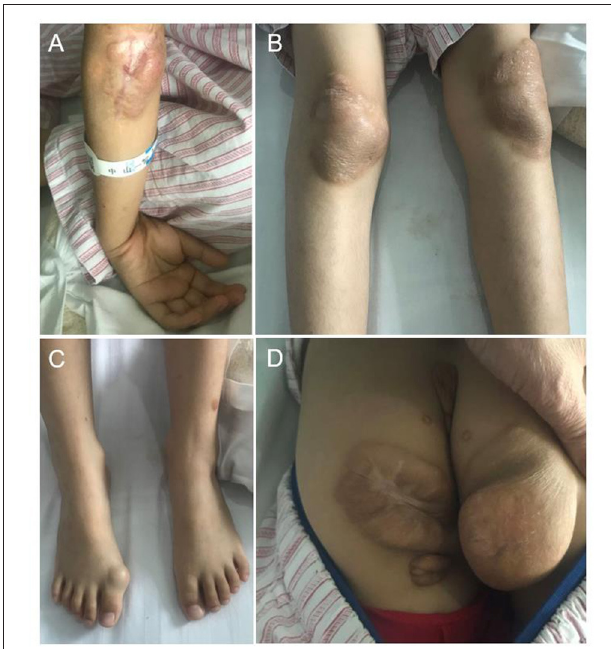
FIGURE 1 | Cutaneous features of the case. (A) Xanthoma on the elbow. (B) Xanthoma on both knees. (C) Xanthoma on the great toe joint. (D) Xanthoma on the